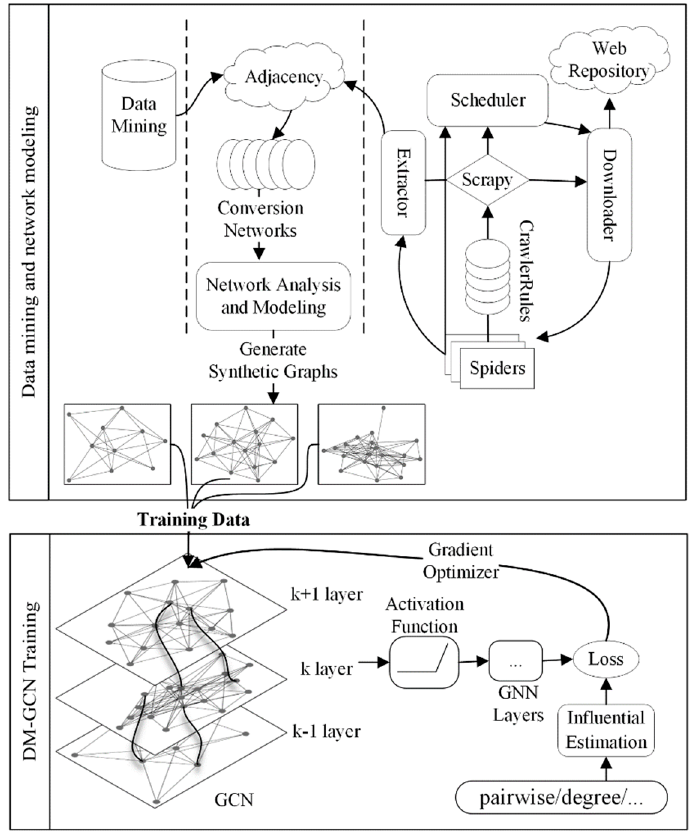
Figure 1. The framework of proposed DMGCN. This method uses data mining to generate synthetic networks as training data and uses GCN to model the relationship between nodes and the network.